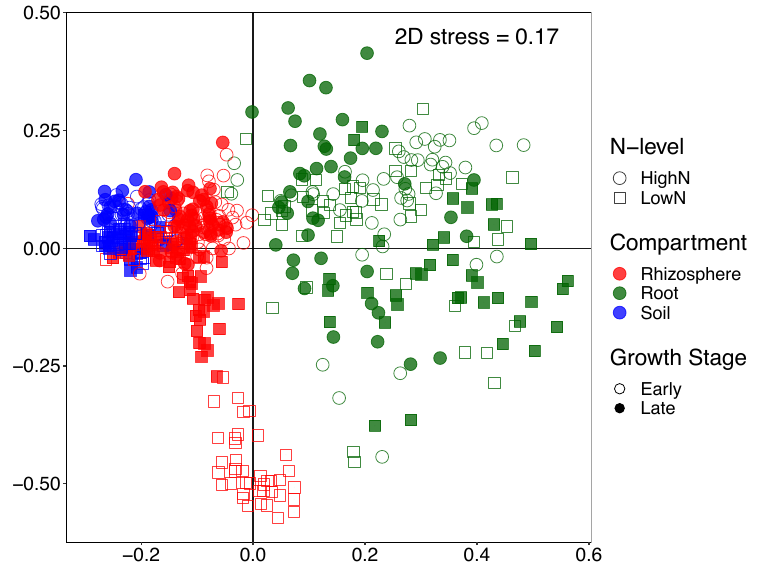
Figure 3. Shifts in β -diversity between soil, rhizosphere, and root endosphere bacterial communities. Non-metric multidimensional scaling (NMDS) based on the Bray-Curtis distance matrix considering all samples in the study including root, rhizosphere and soil, N-levels, and plant growth-stages. Stress value is shown on the